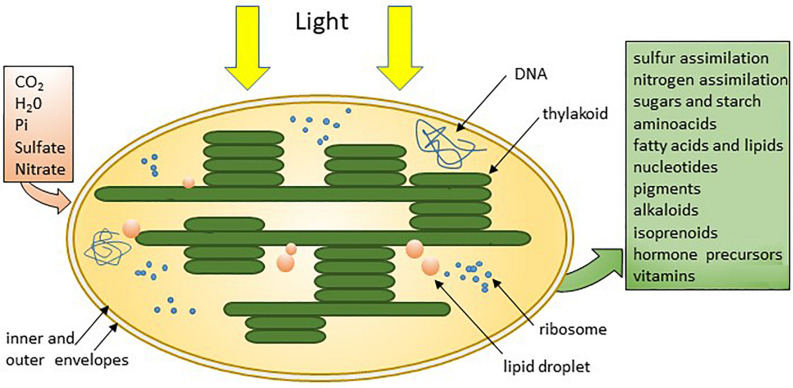
The chloroplast of plants and photosynthetic algae absorbs basic elements and uses sunlight to produce sugar and other organic molecules to fulfil their needs (Kirchhoff, 2019) @JackFalcón.